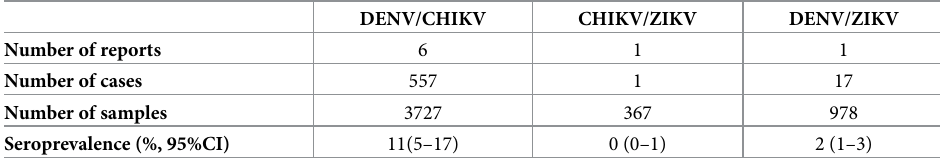
Table 4. Analysis for co-infections of DENV, CHIKV and